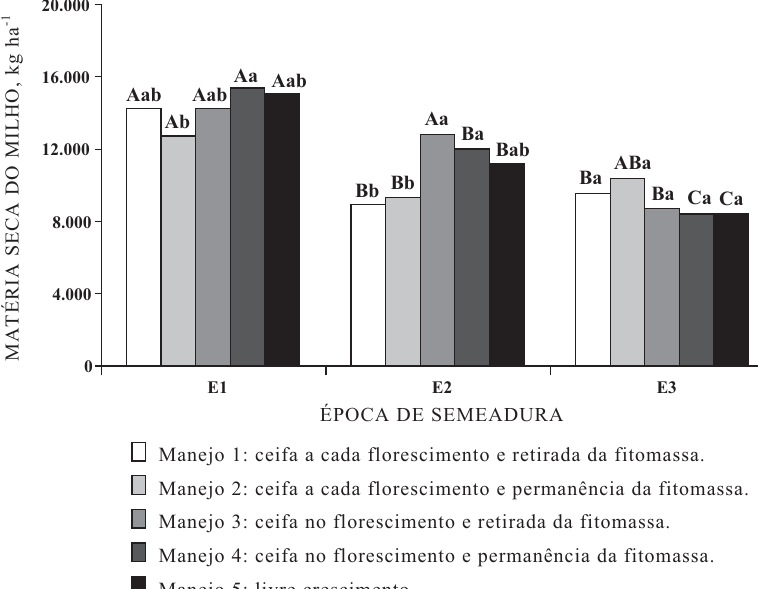
Manejo 1: ceifa a cada florescimento e retirada da fitomassa. Manejo 2: ceifa a cada florescimento e permanência da fitomassa. Manejo 3: ceifa no florescimento e retirada da fitomassa. Manejo 4: ceifa no florescimento e permanência da fitomassa. Manejo 5: livre Figura 2. Quantidade total de matéria seca produzida pelo milheto em função de três épocas de semeadura (E : 29/04; E :21/05; E : 15/06) e do manejo da fitomassa (letras iguais, maiúsculas para época e minúsculas 1 2 3 para manejo, não diferem entre si pelo teste LSD a 5 %).